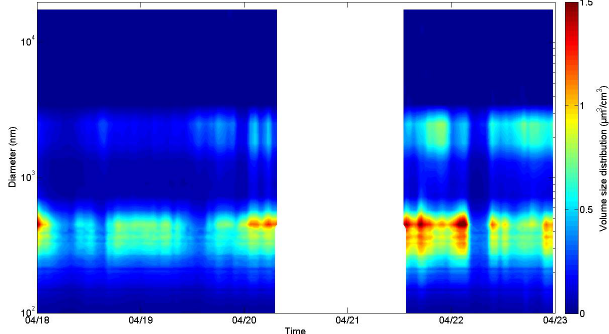
Fig. 13. Particle volume size distribution measured by a SMPS and Grimm OPC on 18–22 April 2010 at the Puy de Dˆome.